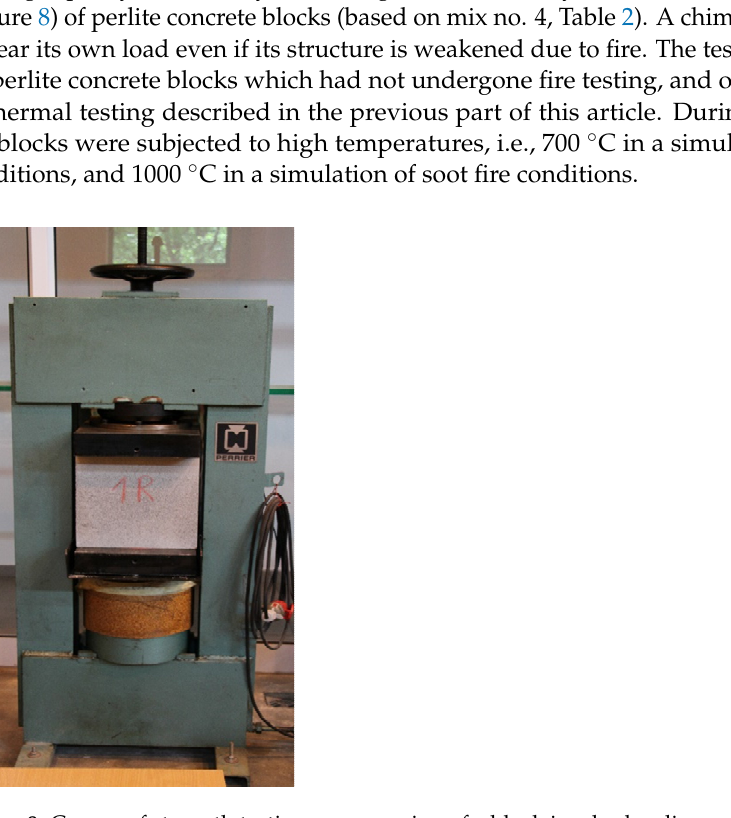
Figure 7. Stand used for fire testing: ( a ) tested chimney on the testing chamber and ( b ) hot exhaust generator.